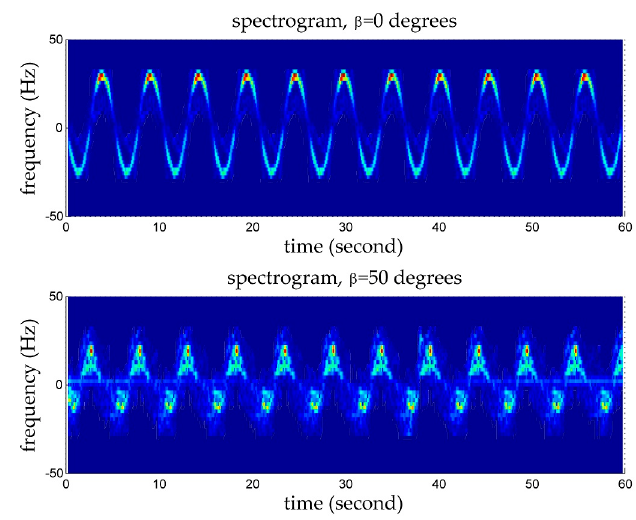
Figure 23. Spectrograms for two measurement directions. The upper figure is the spectrogram which is obtained by pointing the radar transceiver to the wave coming direction, i.e., 𝛽 = 0 degree; the lower figure is obtained by rotating the radar transceiver counter-clockwise 50 degrees from the wave coming direction, i.e., 𝛽 = 50 degrees.